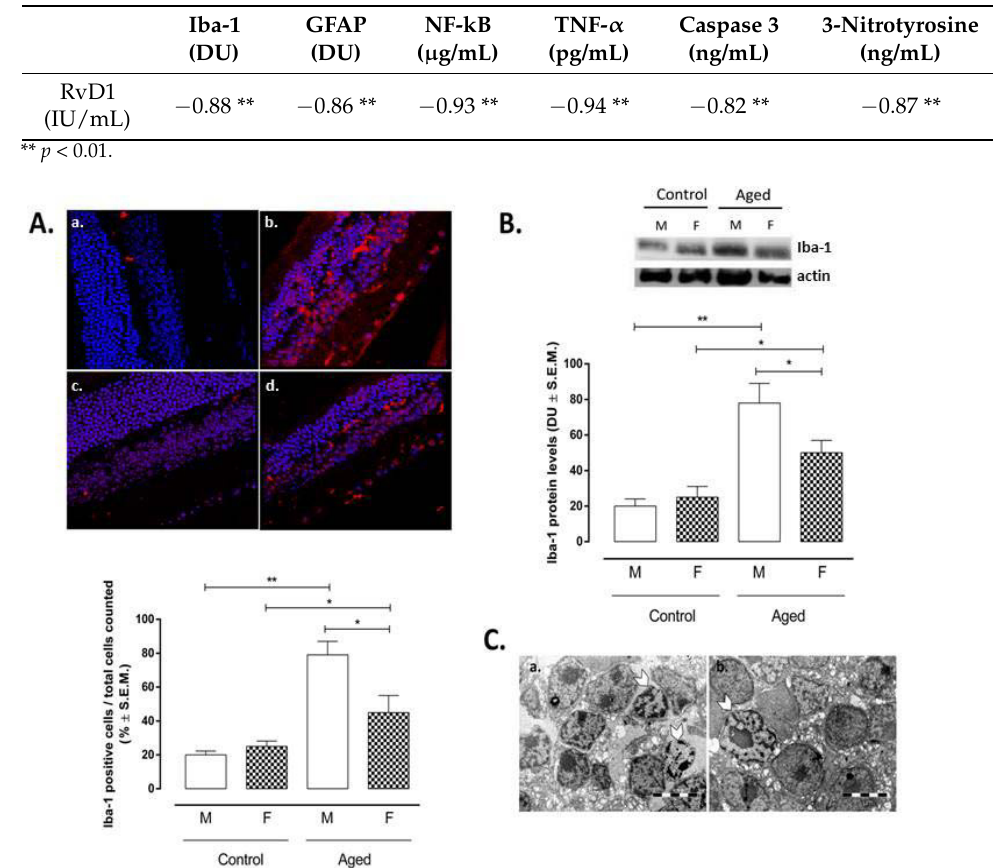
Table 1. Pearson’s r values evaluating the strength of association between RvD1 and retinal markers evaluated.